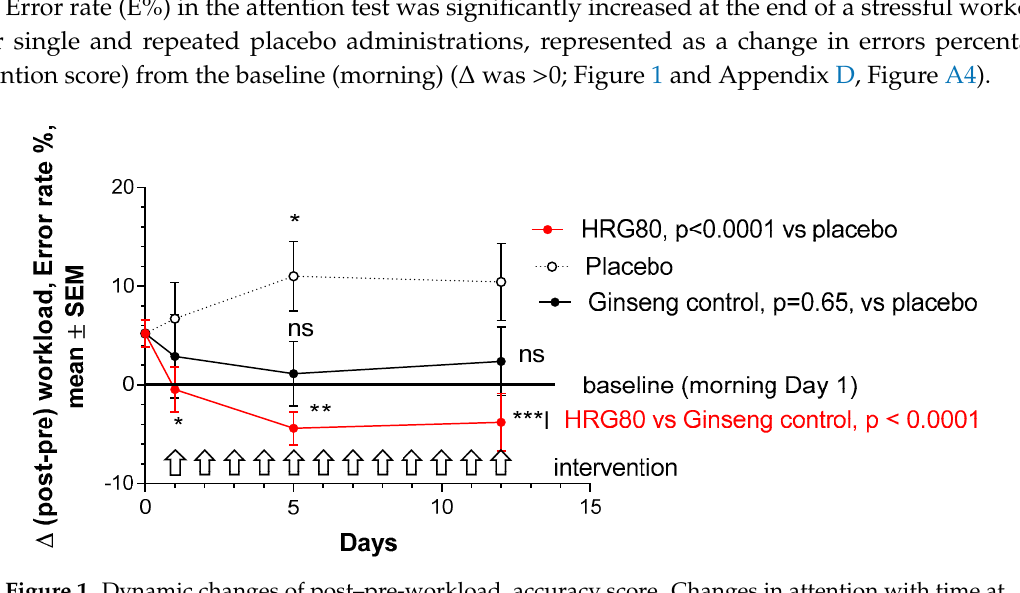
Table 1. Baseline demographic and efficacy-outcome measures. Note: CP, concentration performance; MT, memory test; PS, perceived stress; ns, not significant.